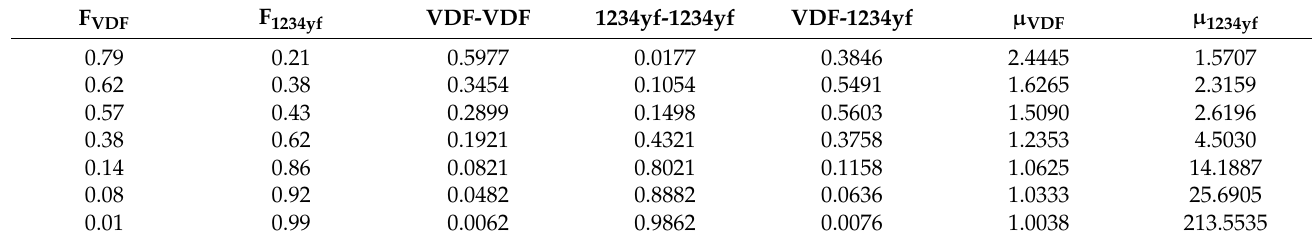
Table 4. Structural data (monomer dyads and mean sequence lengths of PVDF and P1234yf) for the statistical P(VDF- co - 1234yf) copolymers.